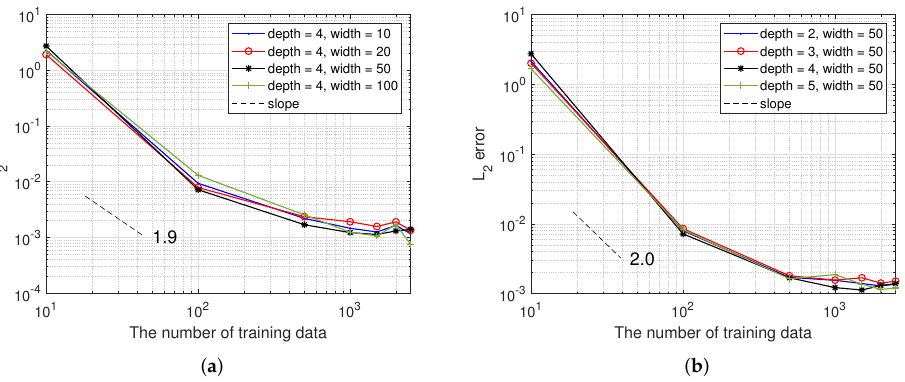
Figure 2. Example 1: Convergence results by using ( a ) different widths and ( b ) different depths.